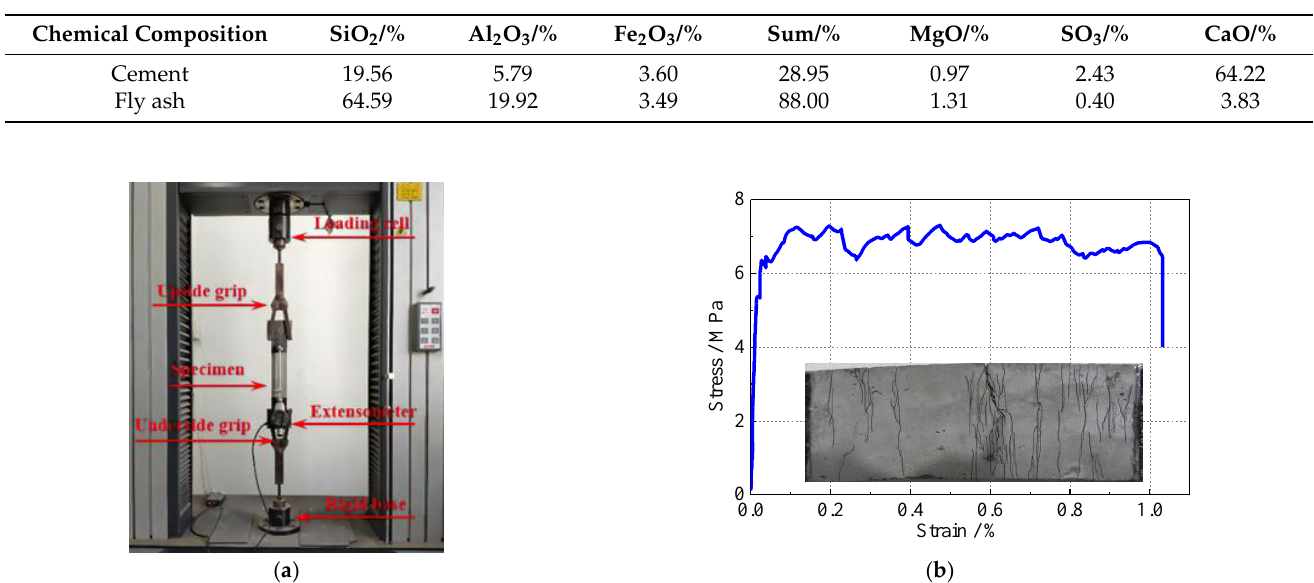
Table 3. Chemical compositions of cement and fly ash.